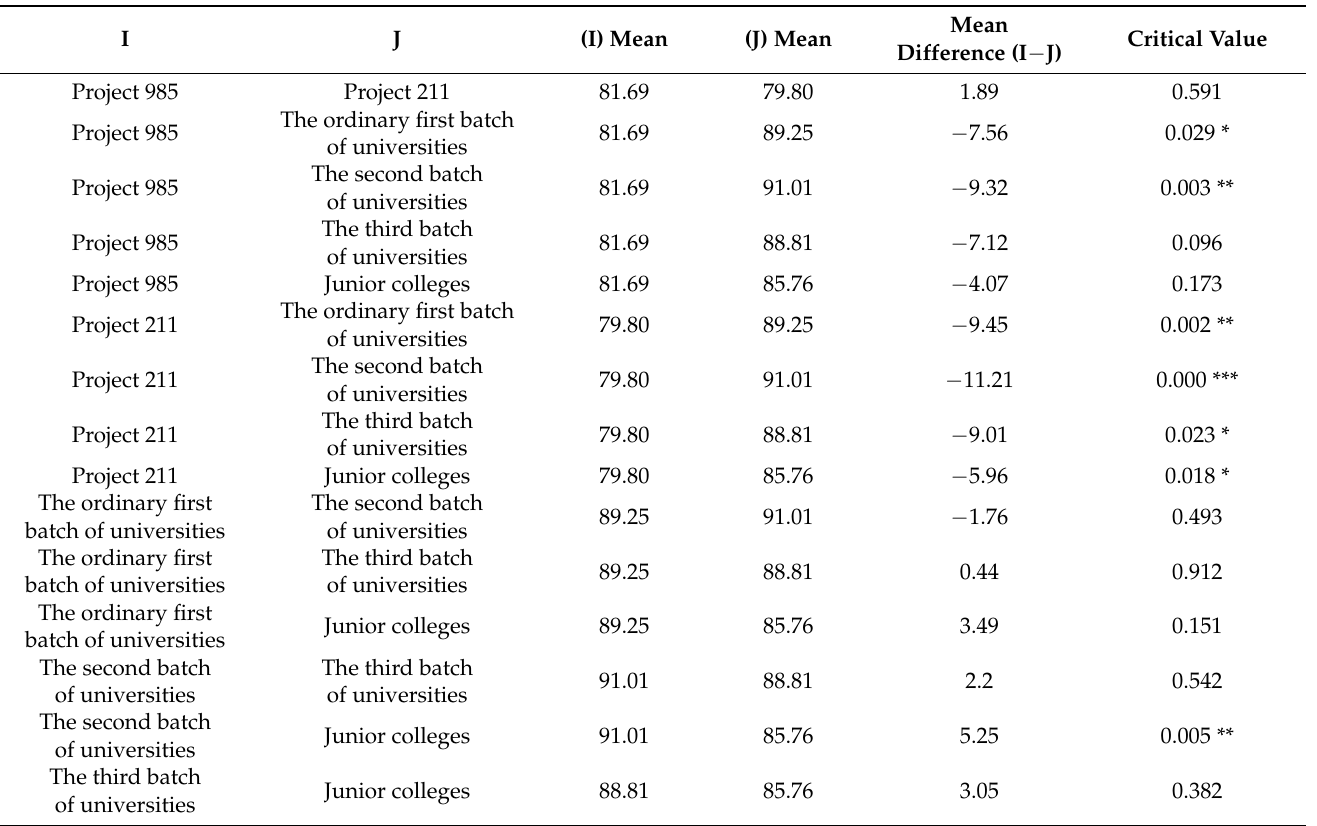
Table 7. Post hoc multiple comparisons of involution involvement at the college